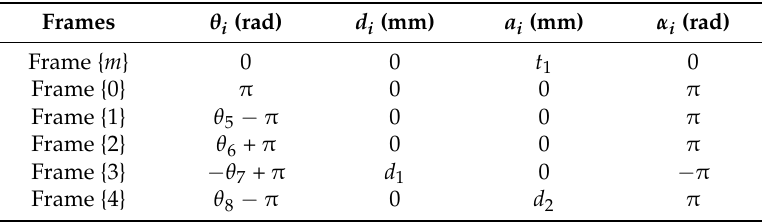
Table A2. The D-H Parameters for the Right